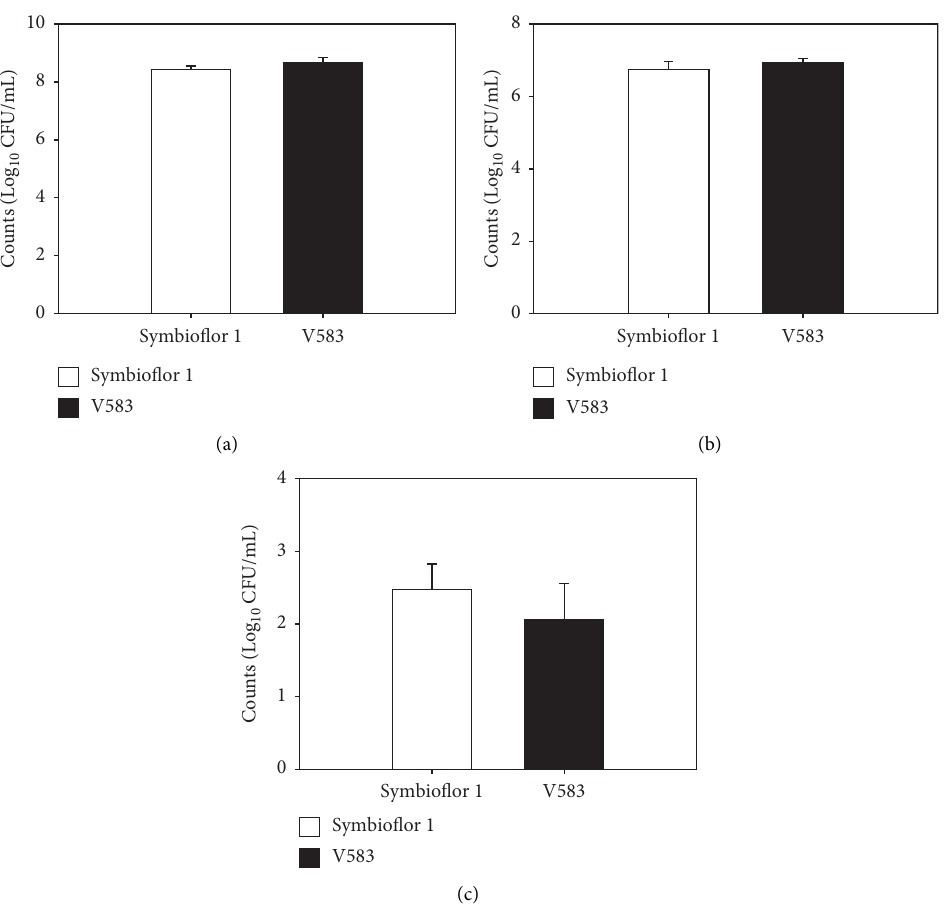
Figure 1: Invasion ability of E. faecalis strains associated with BeWo cells. (a) Colony forming units (CFUs) of E. faecalis strains after incubation; (b) CFUs of invaded E. faecalis ; (c) CFUs of internalized E. faecalis . Values represent mean ± SD. P values were calculated using Student’s t